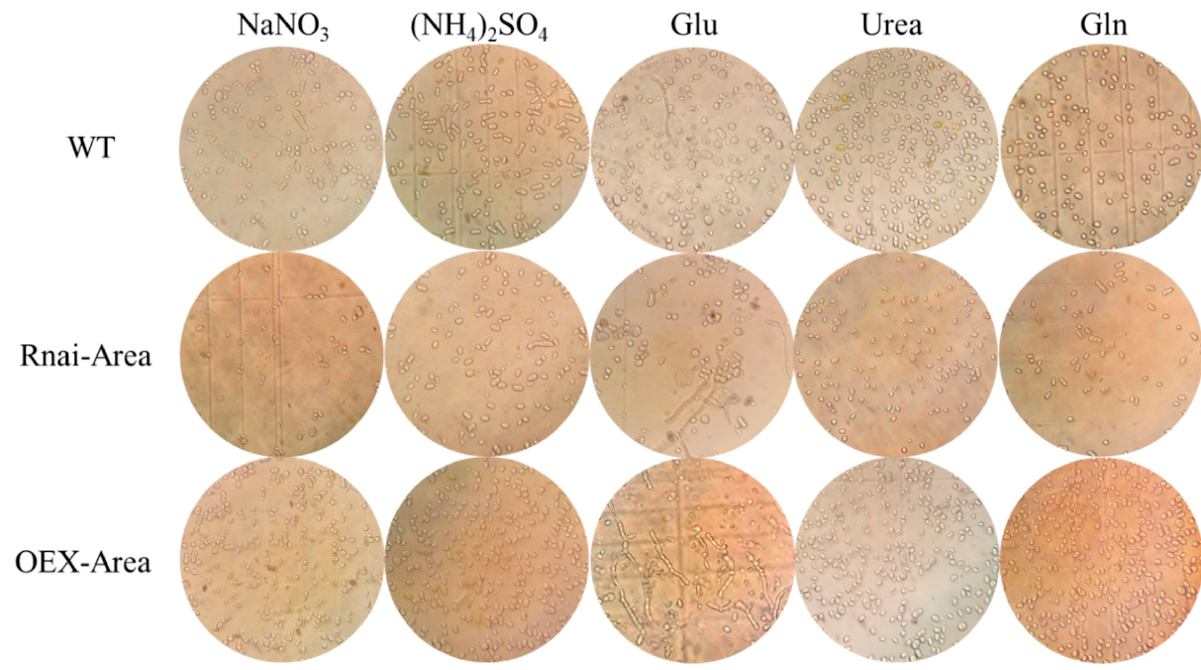
Figure 8. Micromorphology of mutant strains culturing with different nitrogen sources.